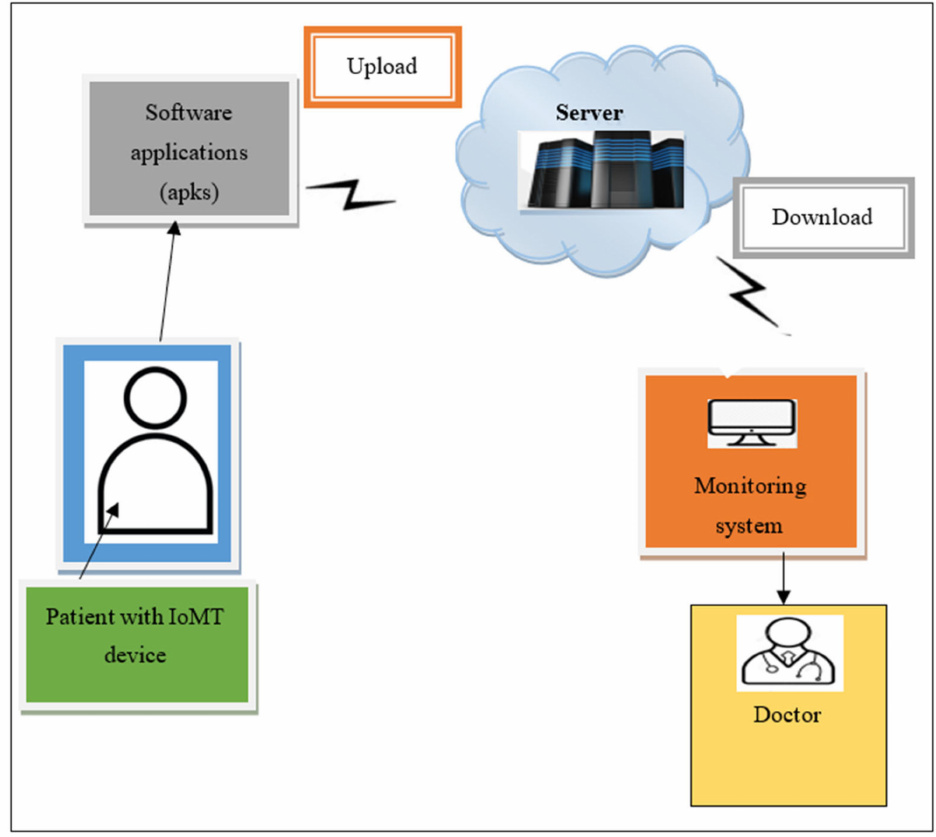
Figure 1. Simple architectural vision of an Internet of Medical Things -based